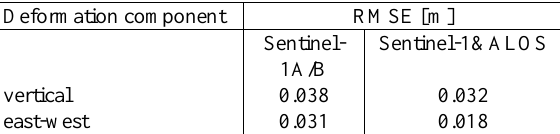
Table 3. RMSE for vertical and horizontal deformation